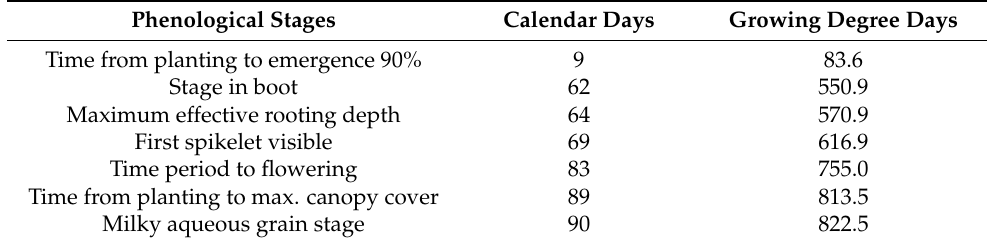
Table 1. Phenological stages in calendar days and cumulative growing degree days (GDD) required from sowing to emergence and for maximum canopy cover of ryegrass ( Lolium perenne L.) across two growing seasons. Phenological Stages Calendar Days Growing Degree Days Time from planting to emergence 90% Maximum effective rooting